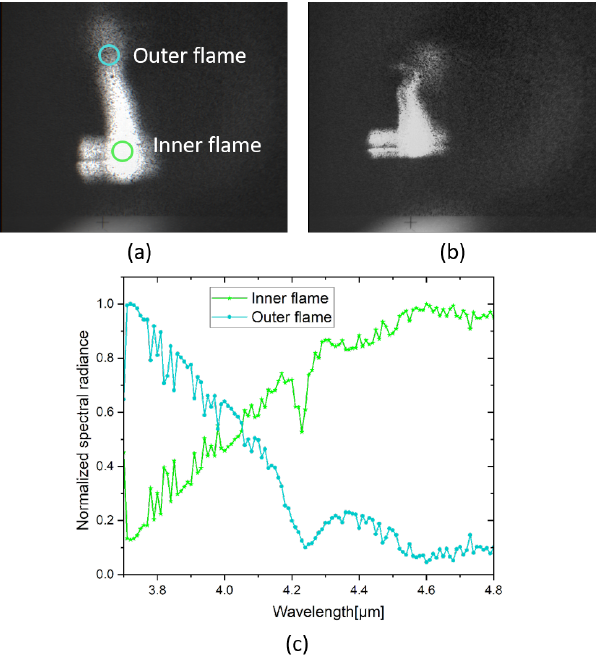
Figure 16. ( a ) Single frame measurement image of candle flame captured by our MWIR-SCSI; ( b ) another frame measurement image of candle flames captured by our MWIR-SCSI; ( c ) the spectral curves selected from the outer flame and inner flame, respectively.